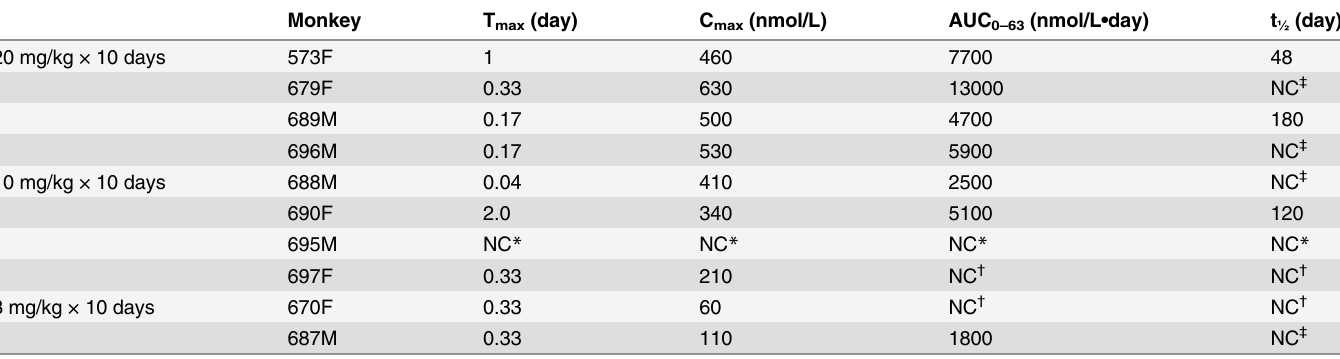
Table 6. Pharmacokinetics of DB829 Pharmacokinetics of DB829 in vervet monkeys with second stage HAT after the 10 th oral dose of